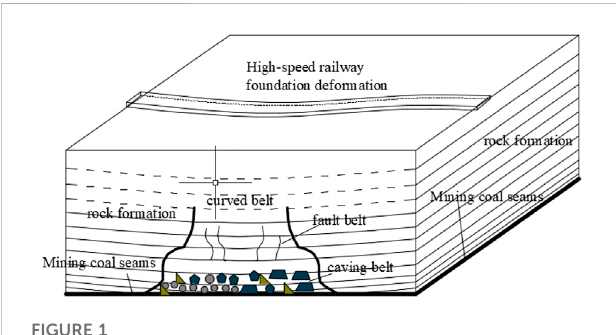
FIGURE 1 Schematic diagram of the coupling chain disaster in goaf